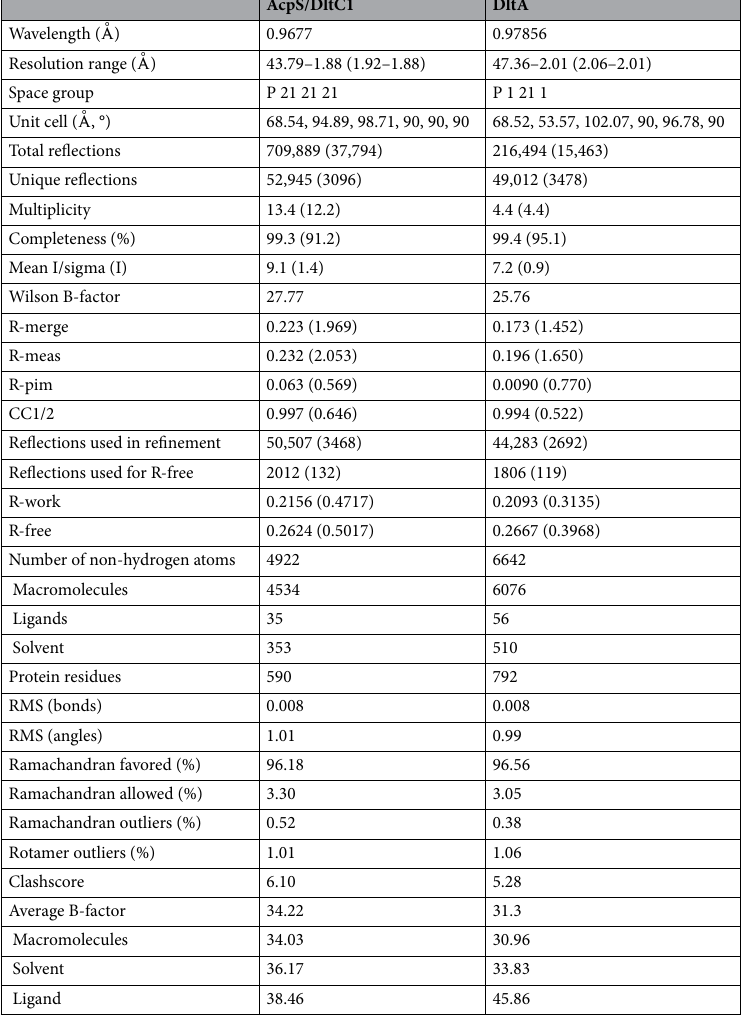
Table 1. Data collection and refinement statistics. Statistics for the highest-resolution shell are reported in